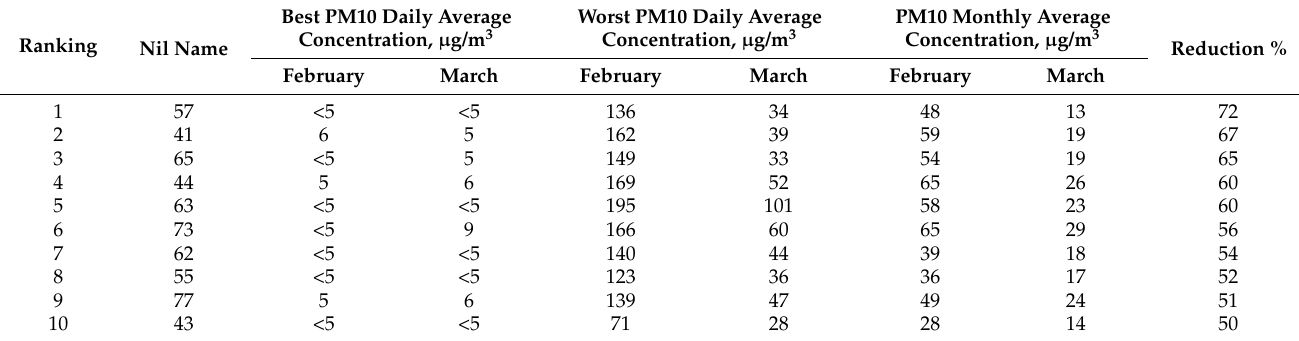
Table 4. Top 10 NILs with the highest PM10 reduction rate between March and February.